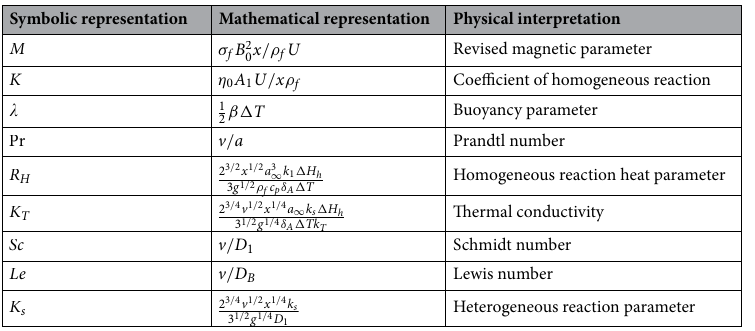
Table 1. Description of parameters.